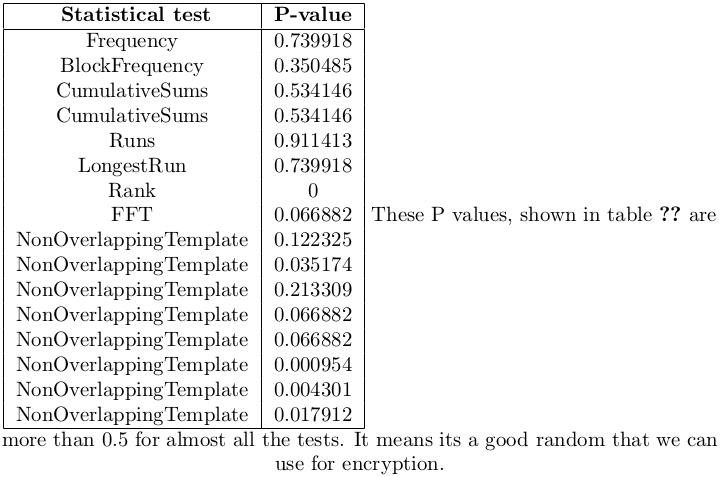
Table from the paper: Hardware Random number Generator for cryptography
Table text:
Statisticaltest
P-value
Frequency
0.739918
BlockFrequency
0.350485
CumulativeSums
0.534146
CumulativeSums
0.534146
Runs
0.911413
LongestRun
0.739918
Rank
0
FFT
0.066882
NonOverlappingTemplate
0.122325
NonOverlappingTemplate
0.035174
NonOverlappingTemplate
0.213309
NonOverlappingTemplate
0.066882
NonOverlappingTemplate
0.066882
NonOverlappingTemplate
0.000954
NonOverlappingTemplate
0.004301
NonOverlappingTemplate
0.017912
ThesePvalues,shownintable??are
morethan0.5foralmostallthetests.Itmeansitsagoodrandomthatwecan
useforencryption.